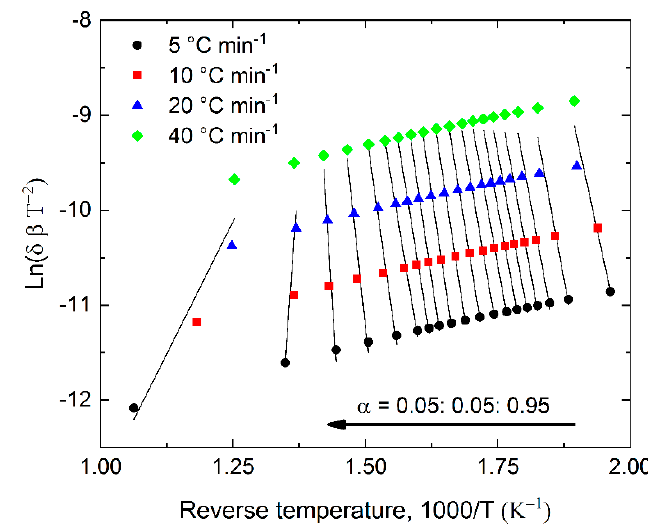
Figure 4. Exemplary linear fit plot using Kissinger–Akahira–Sunose (KAS) method to determine the activation energy for BSG.